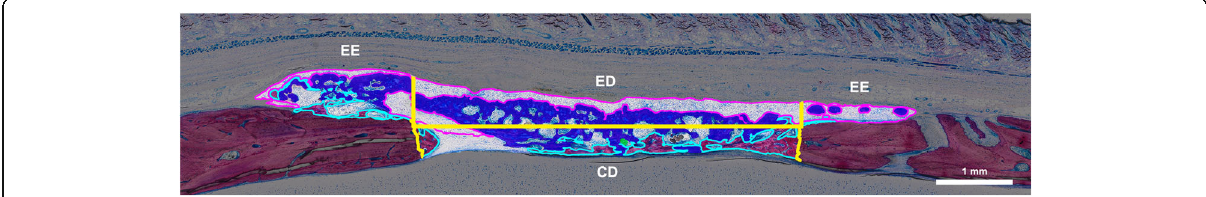
Fig. 1 Regions of interest and tissue classes in the histomorphometric analysis. The defect area is divided (yellow) into three regions of interest: a central defect area (CD) between the defect edges, an ectocranial defect area (ED) directly above the central defect area, and two ectocranial defect edges (EE) laterally to the ectocranial defect area in both directions. Bone with collagen (royal blue fill), bone without collagen (light blue), and mineralized collagen fibers (pink) are